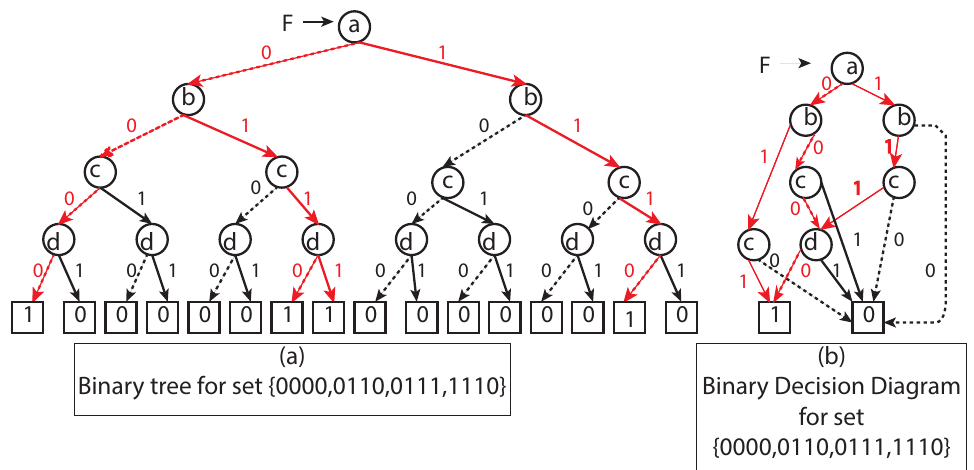
Figure 2. ( a ) Binary decision tree representation for a given set has a fixed size and is large compared to BDD representation. ( b ) Binary decision diagram representation for a given function has compact